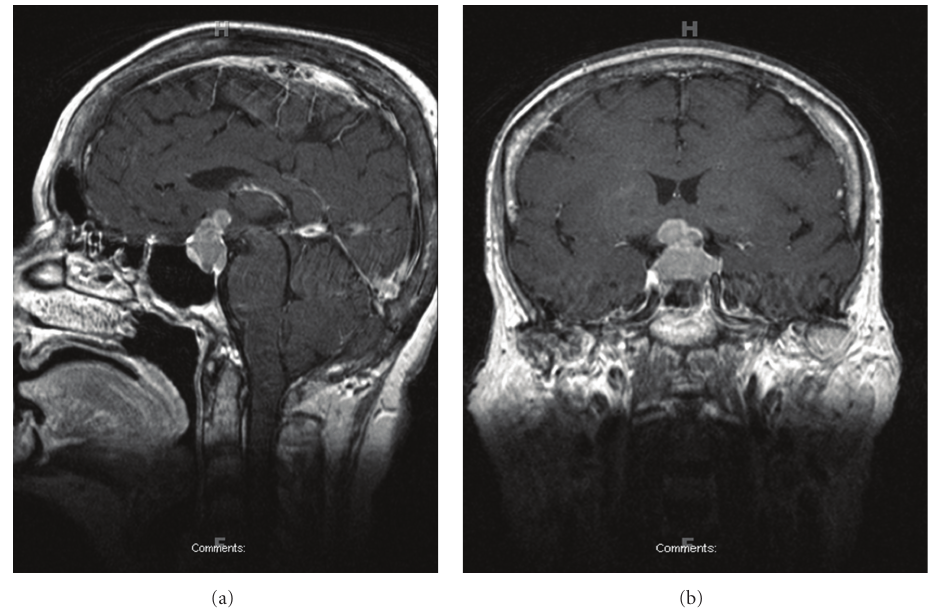
Figure 1: MRI brain, (a) coronal, (b) sagital: 2.0 × 1.2 × 1.1 cm bilobed homogeneous enhancing mass expanding the sella with compression of the optic chiasm.